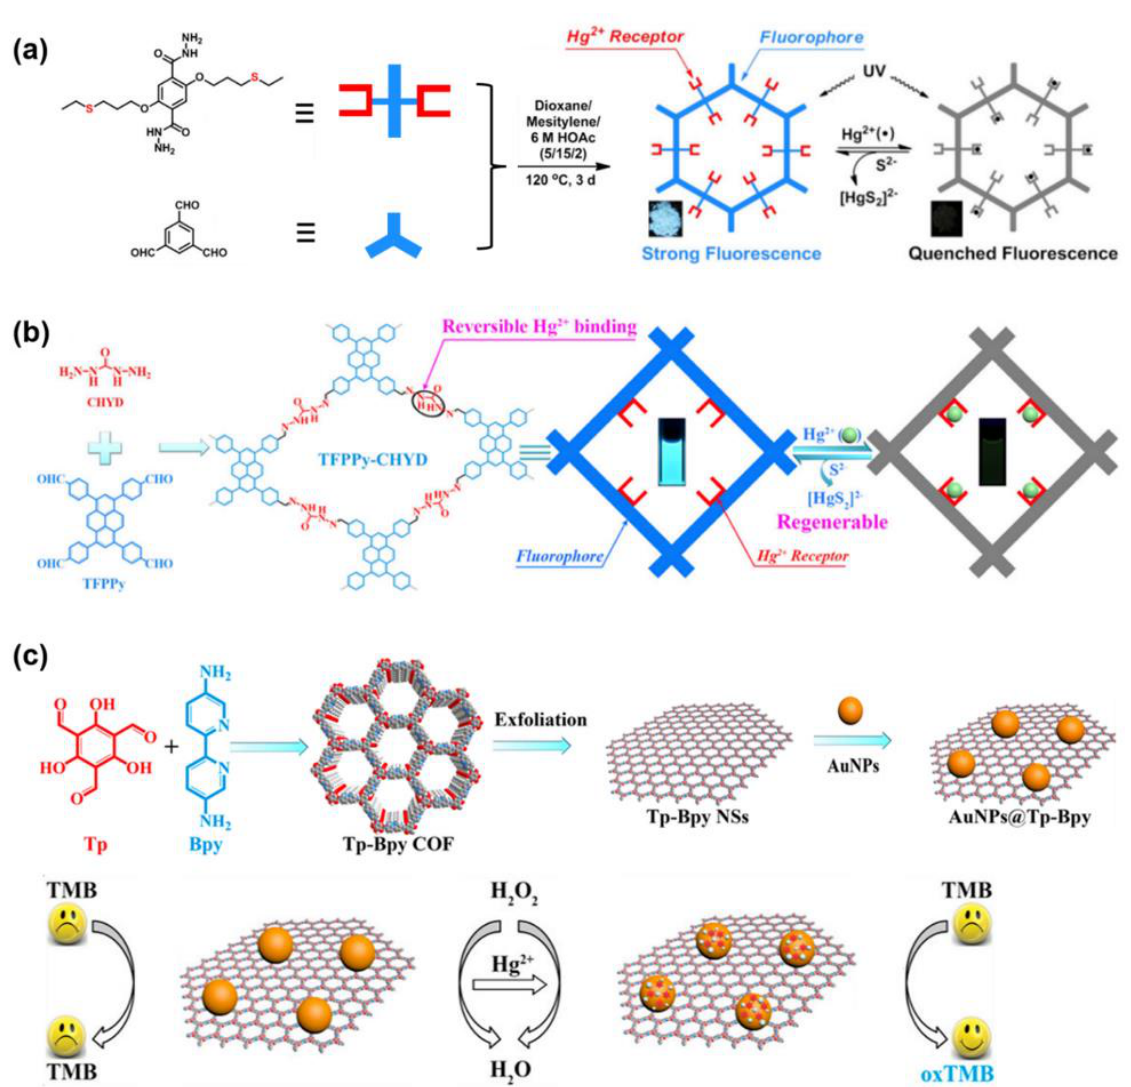
Figure 7. ( a ) COF − LZU8 for Hg 2+ detection via fluorescence quenching [42]. Copyright 2016 American Chemical Society; ( b ) TFPPy − CHYD for Hg 2+ detection via fluorescence quenching [73]. Copyright 2020 American Chemical Society; ( c ) Tp − Bpy NSs for Hg 2+ detection via catalytic oxidation of TMB [29]. Copyright 2019 American Chemical